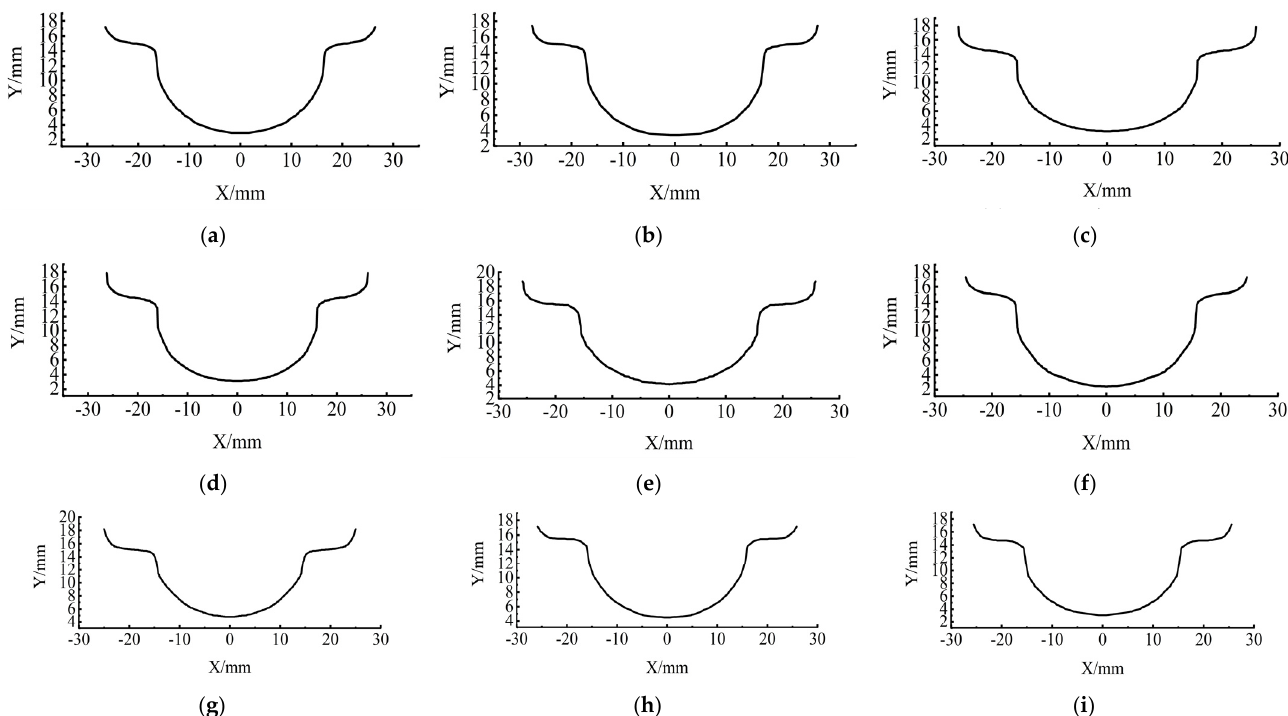
Figure 10. Comparison of the experimental results. ( a ) v = 11 m/s, η = 500 Pa·s, ( b ) v = 12 m/s, η = 500 Pa·s, ( c ) v = 13 m/s, η = 1000 Pa·s, ( d ) v = 11 m/s, η = 1000 Pa·s, ( e ) v = 12 m/s, η = 1000 Pa·s, ( f ) v = 13 m/s, η = 1000 Pa·s, ( g ) v = 11 m/s, η = 2000 Pa·s, ( h ) v = 12 m/s, η = 2000Pa·s, ( i ) v = 13m/s, η = 2000 Pa·s.